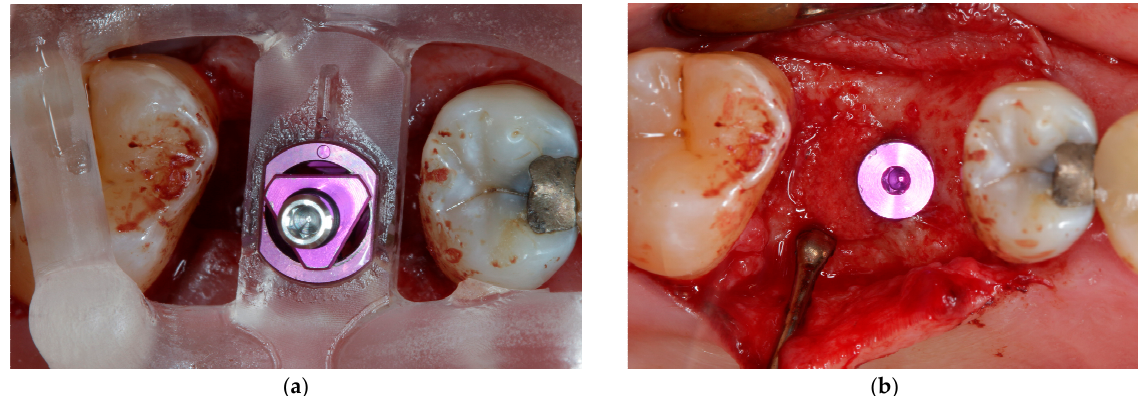
Figure 2. Implant placement: ( a ) implant placement through fully guided surgical guide; ( b ) inserted implant (Camlog Screw Line Promote Plus 4.3 × 9 mm).